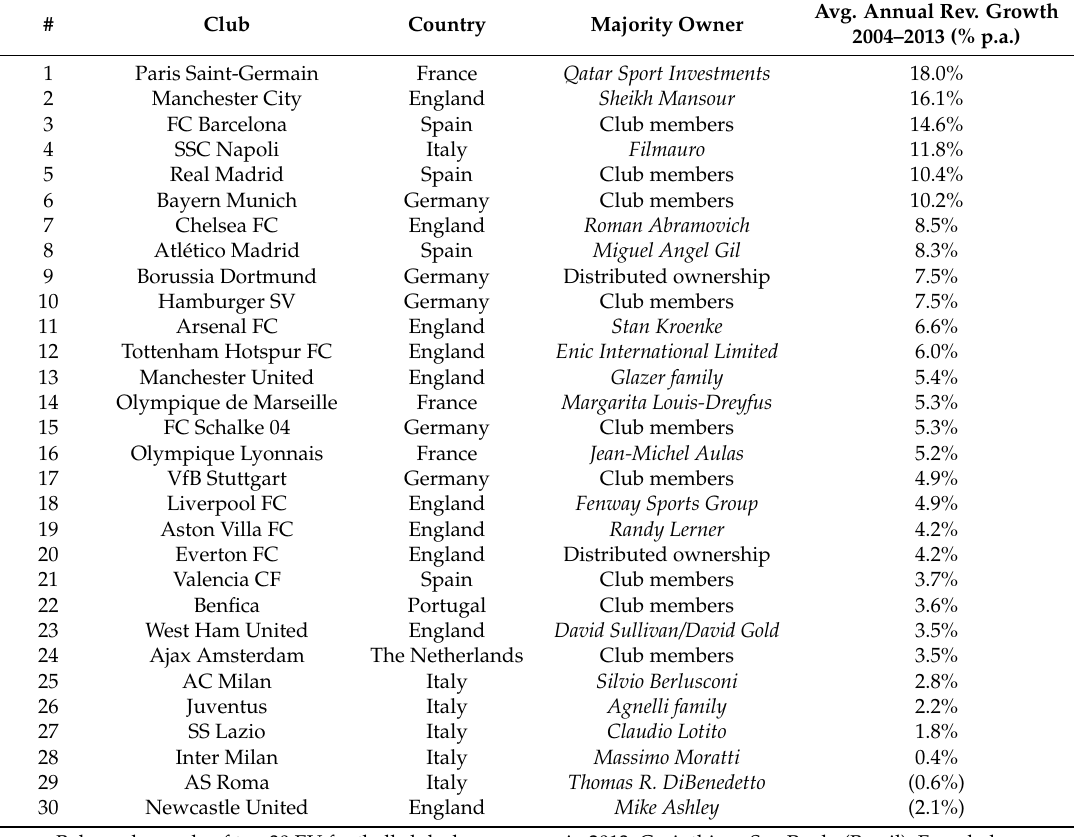
Table 1. Financial growth of top 30 EU football clubs from 2003/04 to 2012/13.